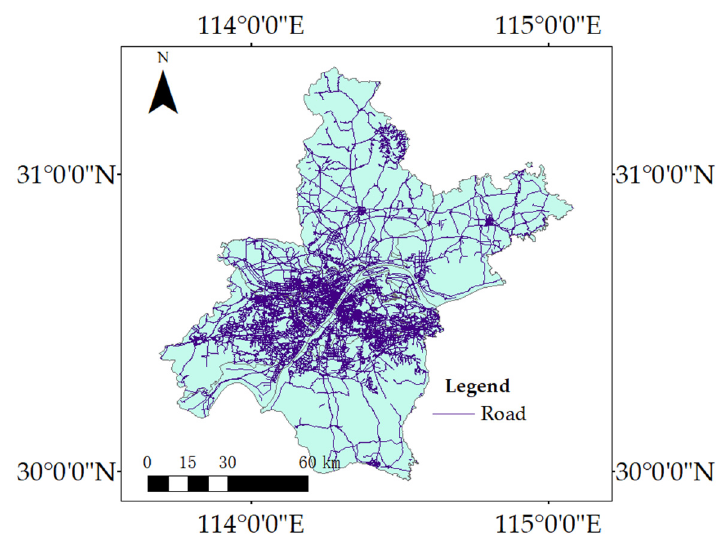
Figure 2. City roads extracted from OpenStreetMap.